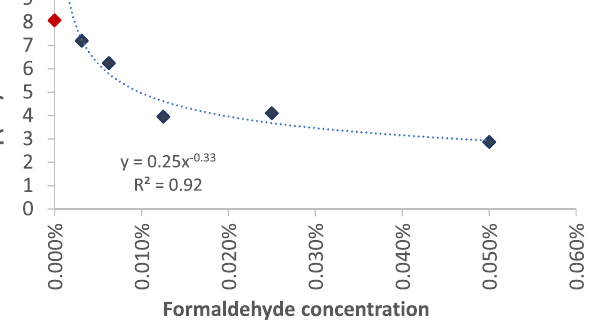
Figure 3. Correlation of dCq value (weighted average, wa) and formaldehyde concentration used for cell damaging. Various formaldehyde concentrations have been used to introduce different densities of blocking sites for DNA amplification. The weighted average was calculated from dCq value intervals of Control-DNA. The weighted average dCq value decreased exponentially by increasing the formaldehyde concentration indicating damaging of single cell DNA (see blue diamonds). The red diamond gives the weighted average dCq value of non-treated cells used as a control.